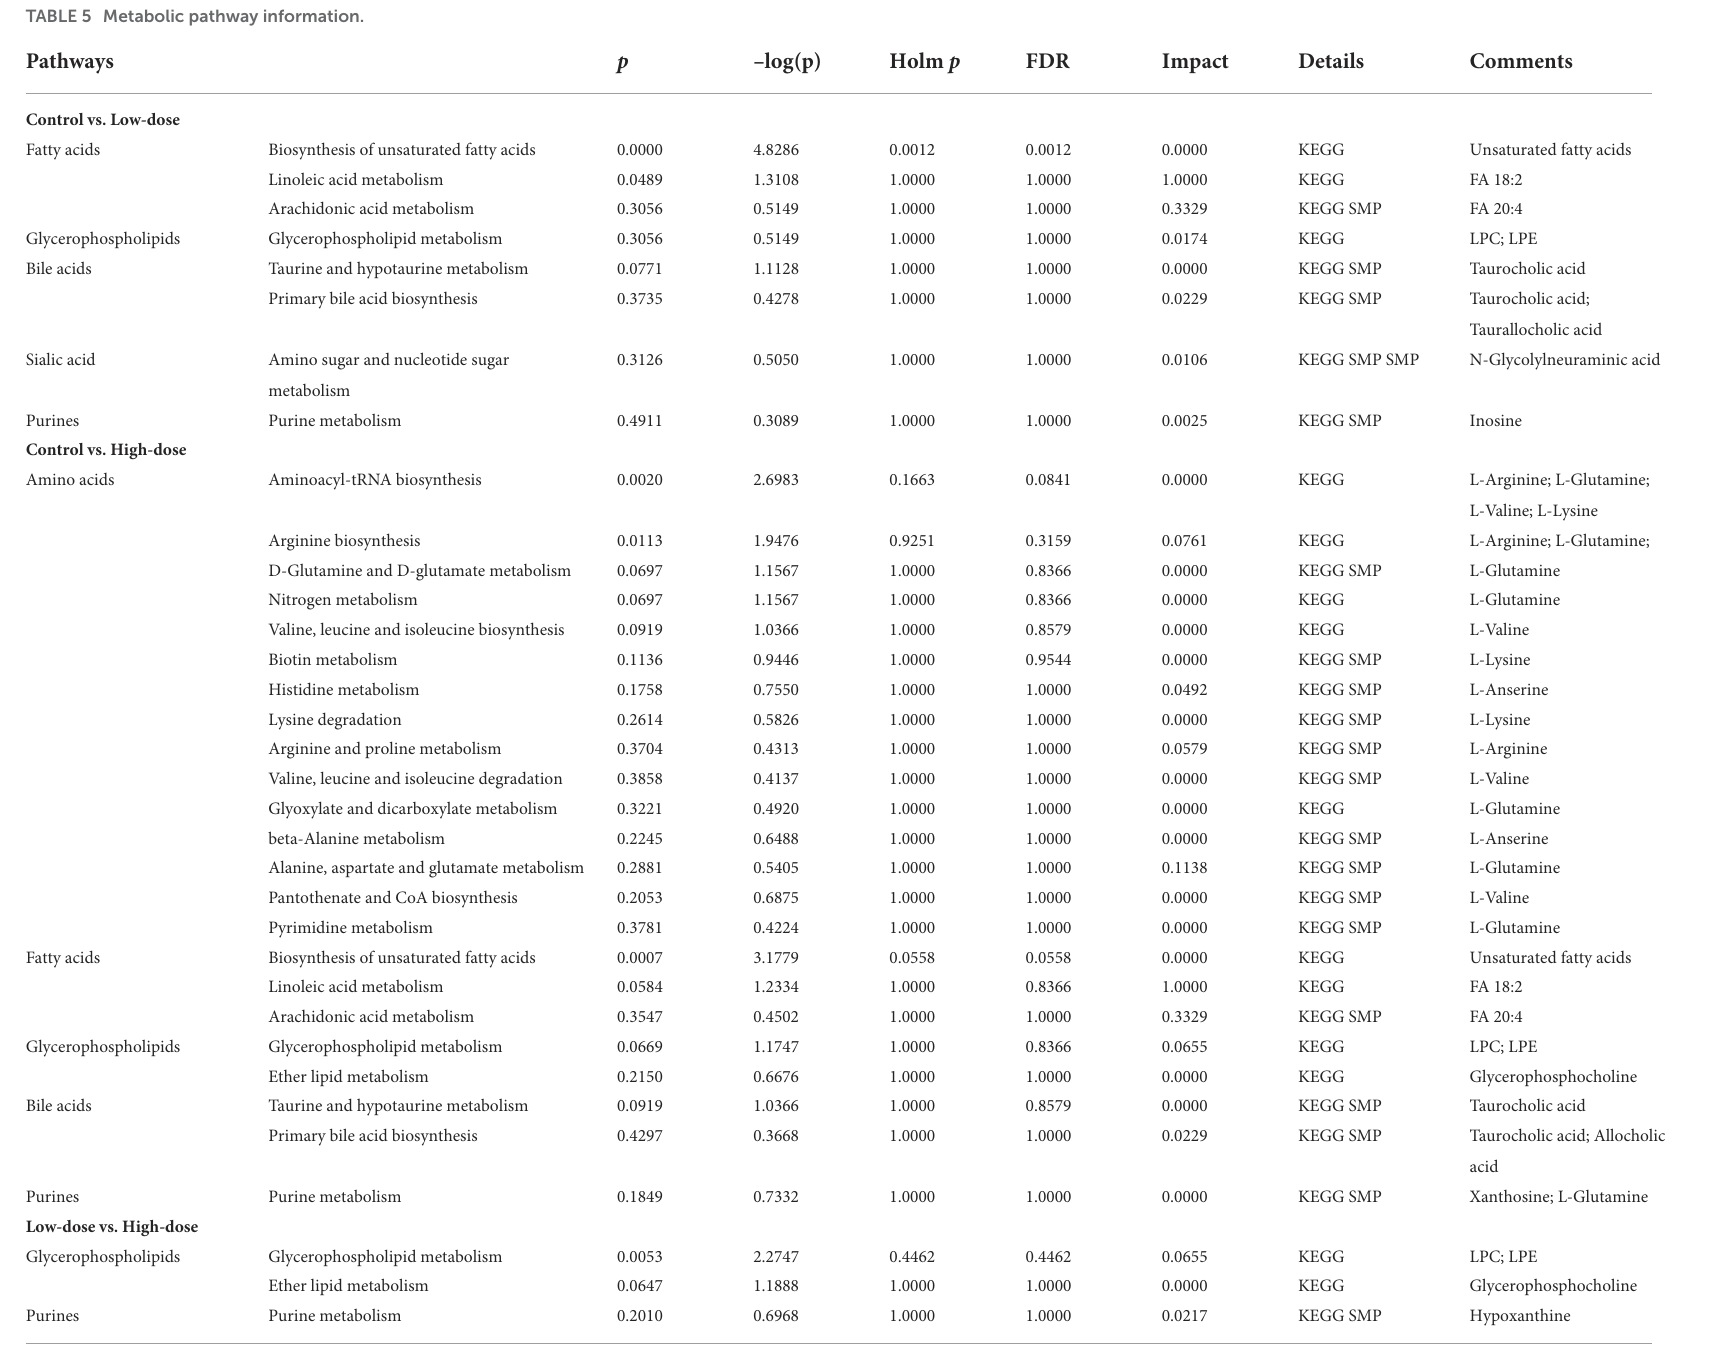
TABLE 5 Metabolic pathway